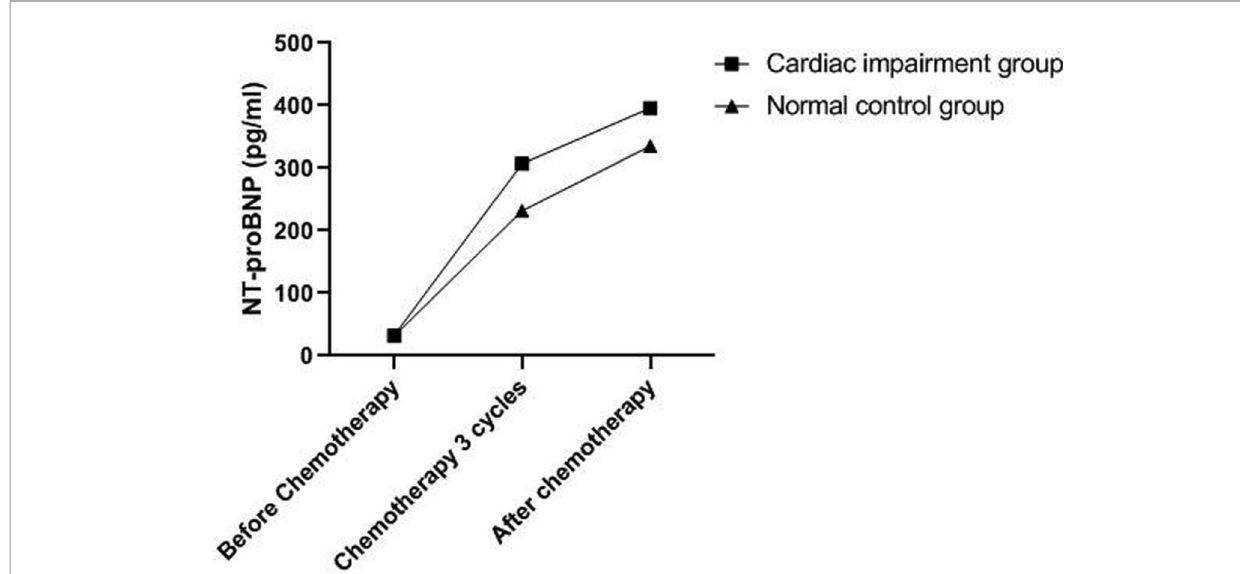
FIGURE 2 | Change trend of NT-proBNP level in patients of two groups.